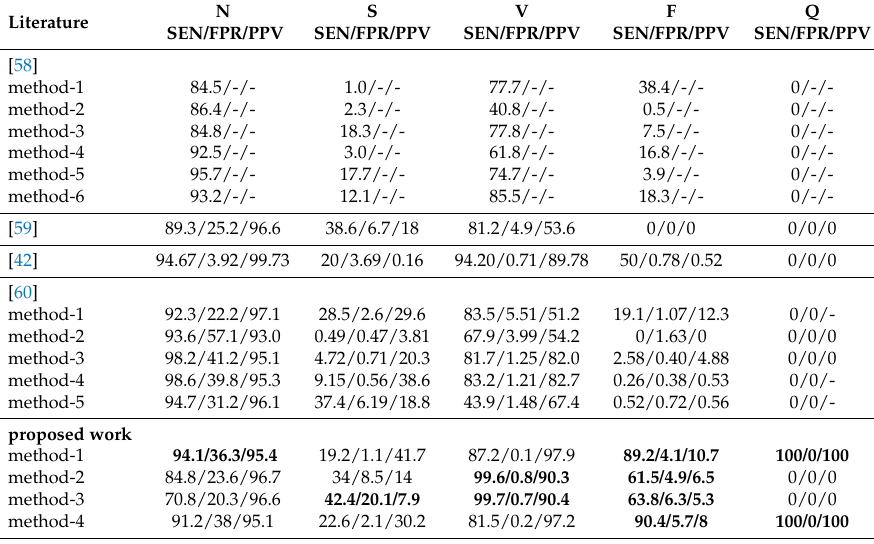
Table 28. Performance comparison with recent literature (N, S, V, F, and Q